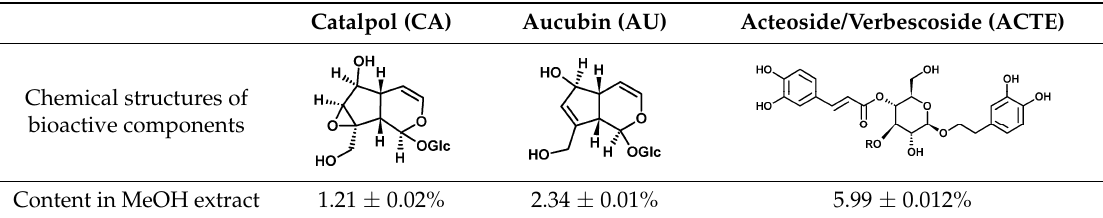
Table 1. Chemical description of Catalpol, Aucubin, and Acteoside in plantain ( Plantago lanceolata ). Catalpol (CA)